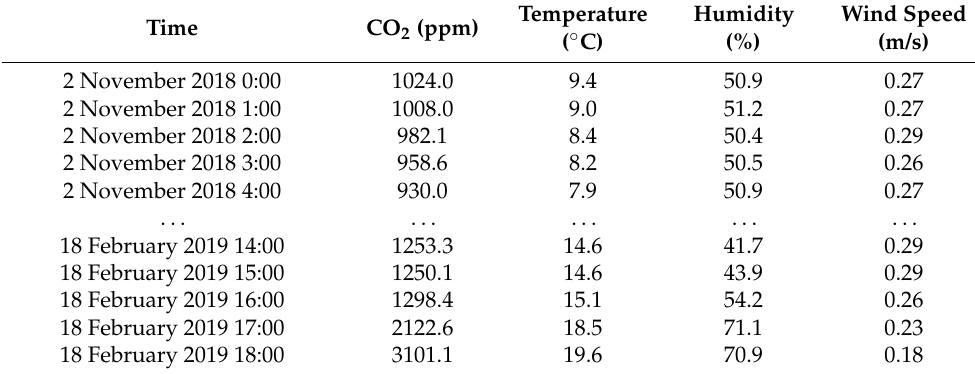
Table 2. The environmental parameters of the pig